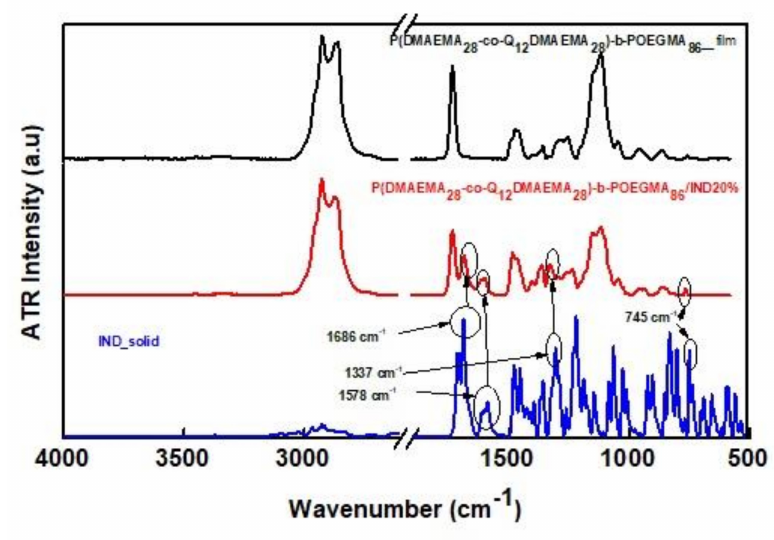
Figure 10. Comparative ATR-FTIR spectra of the mixed P(DMAEMA 28 -co-Q 12 DMAEMA 28 )- b - POEGMA 86 /IND20% aggregates the P(DMAEMA 28 -co-Q 12 DMAEMA 28 )- b -POEGMA 86 empty ag- gregates and IND in the solid state.Note: The ATR-FTIR spectra of aqueous solutions of random diblock copolymer and mixed nanoassemblies of random diblock copolymer with IND emanated after the evaporation of water by using nitrogen, so that the water absorption peaks would not intervene with the characteristic absorption peaks that would reveal the interactions between IND and the random diblock